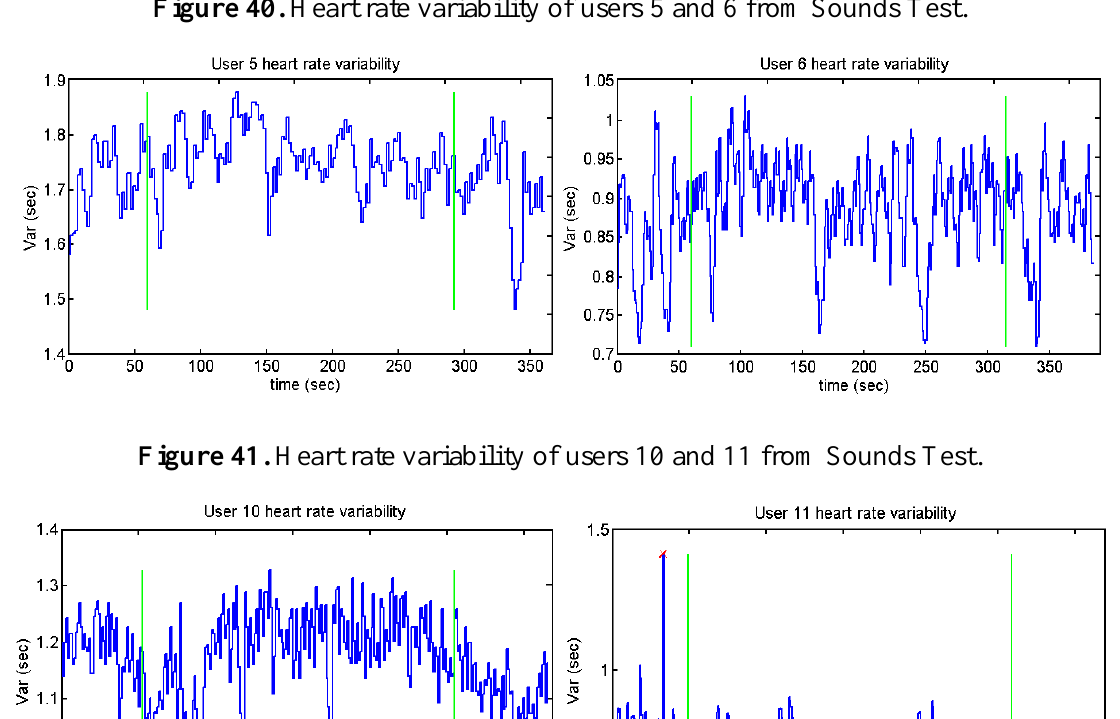
Figure 40. Heart rate variability of users 5 and 6 from Sounds Test.